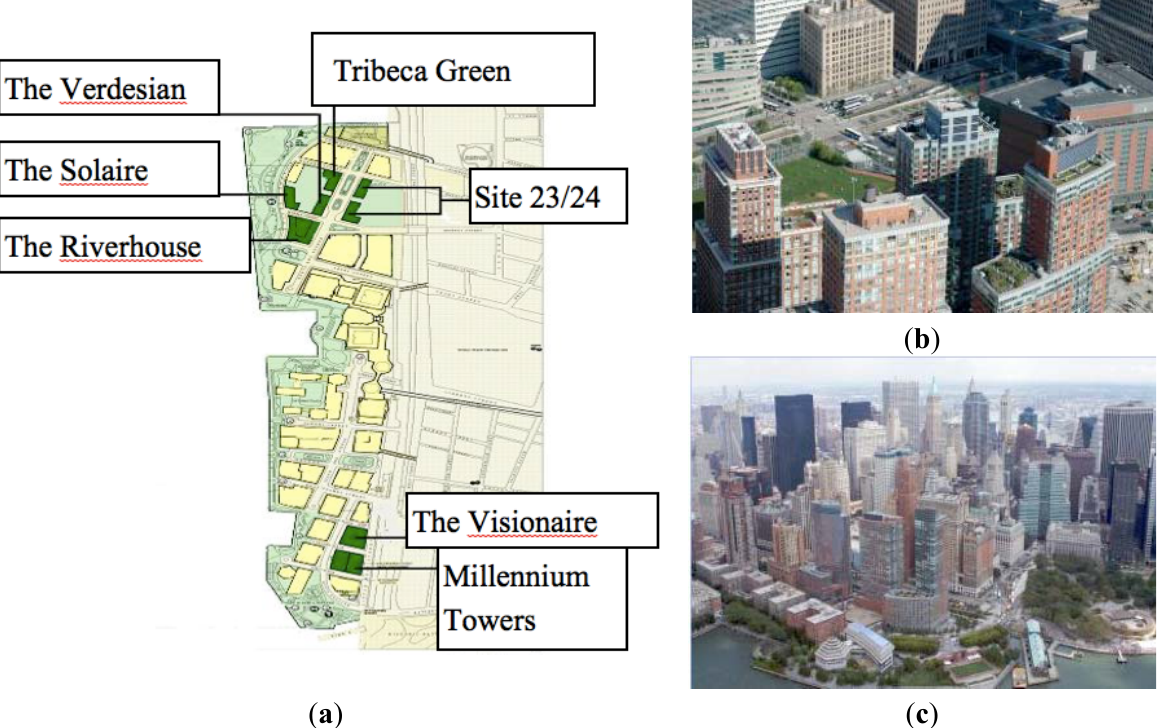
Figure 1. ( a ) Plan of the Battery Park City (BPC) development. Photographs of the site looking: ( b ) Southeast and ( c ) Northeast